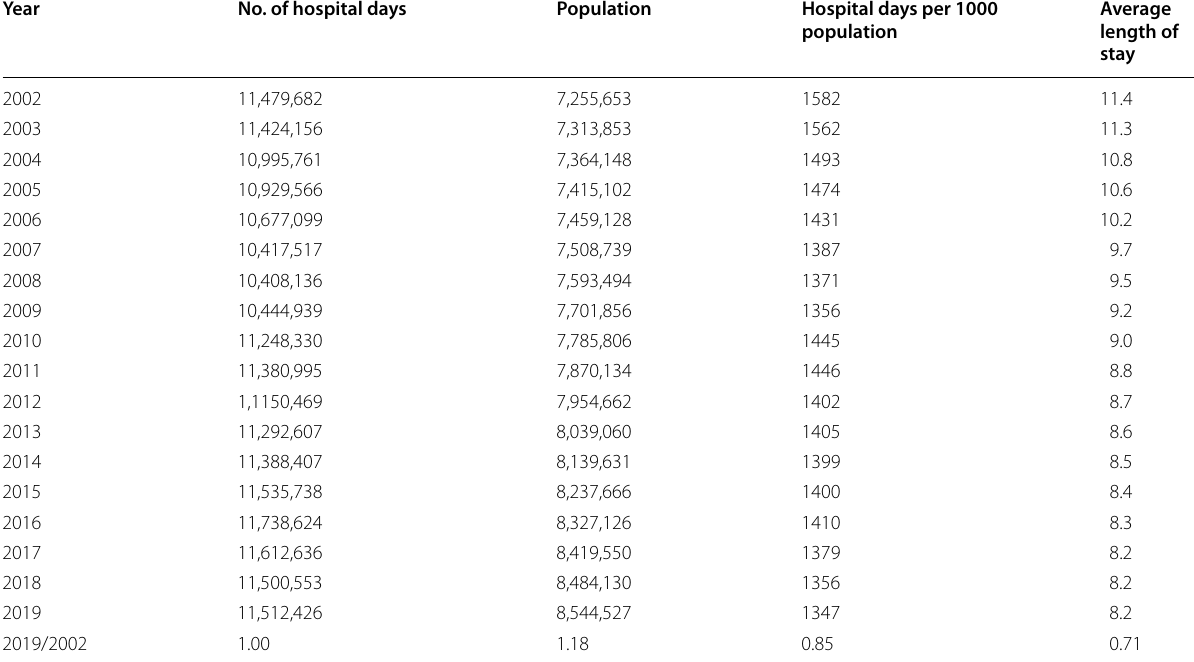
Table 2 Hospital utilization for all causes except V–Z,